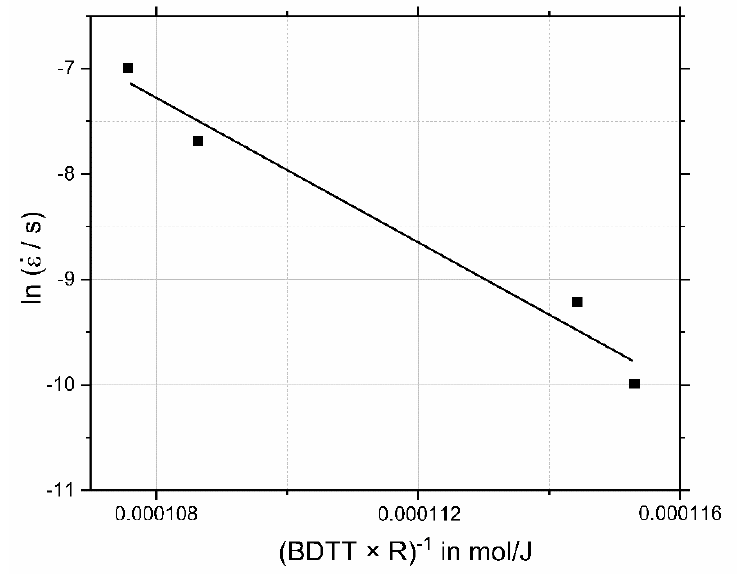
. ε Figure 6. The linear relationship between ln ( ) and (BDTT × R) − 1 , full square symbols are experimental Figure 6. The linear relationship between ln ( (cid:2013)(cid:4662) ) and (BDTT × R) − 1 , full square symbols are experimental results from this study, the straight line is the linear best fit of results from this study, the straight line is the linear best fit of data.